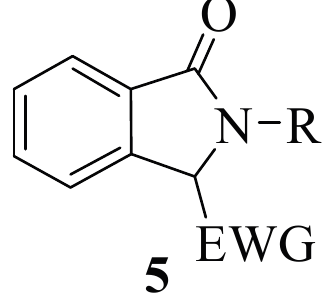
Figure 2. General structure of potentially nucleophilic 3-substituted